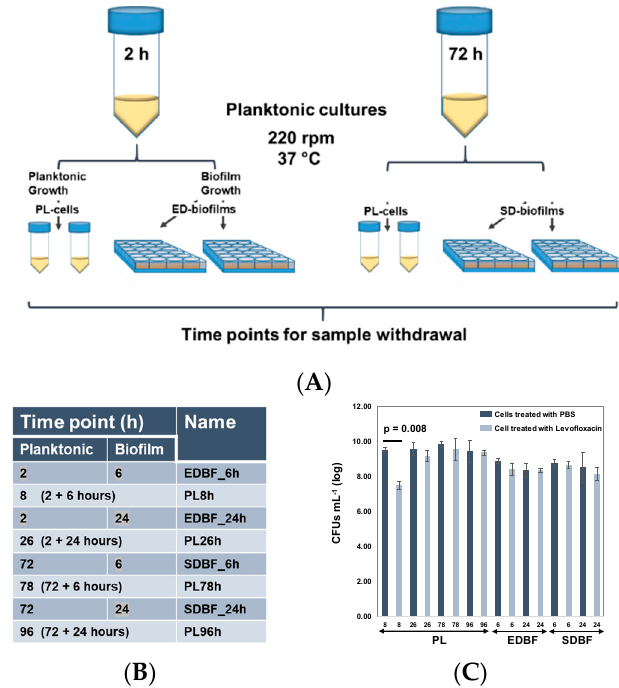
Figure 1. ( A ) Workflow used for preparing the planktonic (PL) and biofilm (BF) cell cultures of S. aureus ATCC25923. EDBF refers to biofilm culture initiated with planktonic cells at exponential growth phase (initiation culture propagated for 2 h). SDBF refers to biofilm culture initiated with planktonic cells at stationary growth phase (initiation culture propagated for 72 h). ( B ) Time points of sample withdrawal for surfaceomics and phenotypic analyses. All samples were prepared in biological triplicates. ( C ) Susceptibility of the PL, EDBF, and SDBF cells at the indicated time points was tested with 400 µM levofloxacin. The error bars denote the standard deviation of the log 10 -transformed bacterial concentrations from three individual experiments. The difference between the means of treated and nontreated PL8 h cells is statistically significant (a paired t-test). The error bars indicate standard deviation ( n =16).